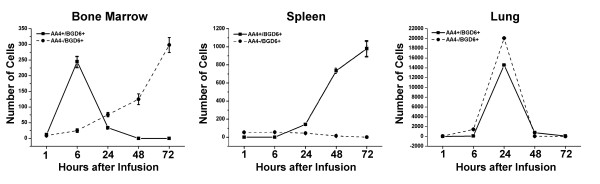
MCcp home to the bone marrow . MCcp (AA4-/BGD6+) and MCp (AA4+/BGD6+) were immunomagnetically isolated from the bone marrow and labelled with CellTracker Green CMFDA™ or CellTracker Red CMTPX™ respectively. The labelled cells were then infused into the tail vein of rats and at various times after infusion bone marrow (A), spleen (B) and lungs (C) were collected. The entire tissue was dissociated and the presence of labelled cells analyzed by FACS. The data is expressed as the number of labelled mast cells/105 cells. The average of 3 independent experiments ± SD is shown.